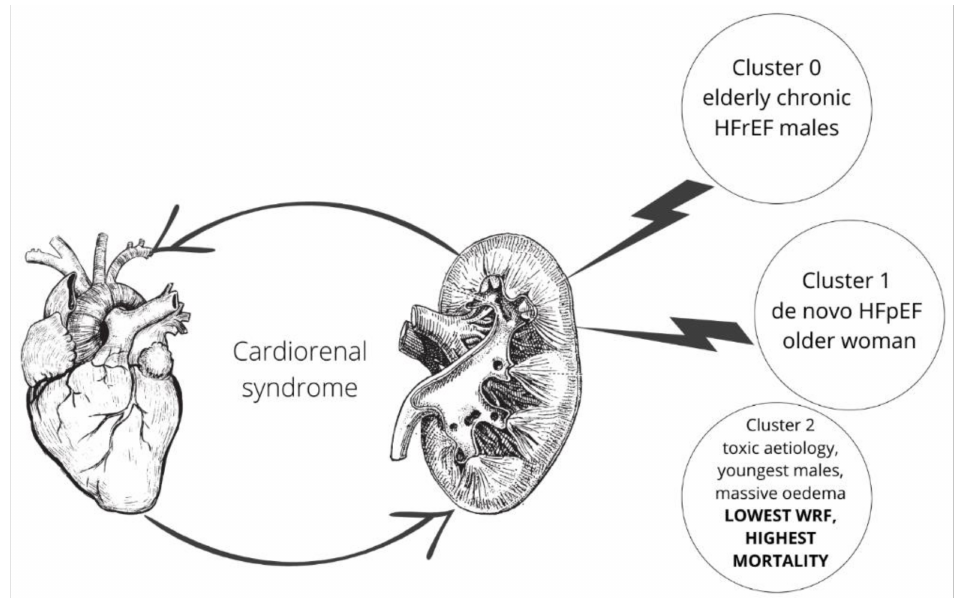
Figure 2. Summary of the most important cluster characteristics and association with renal function.